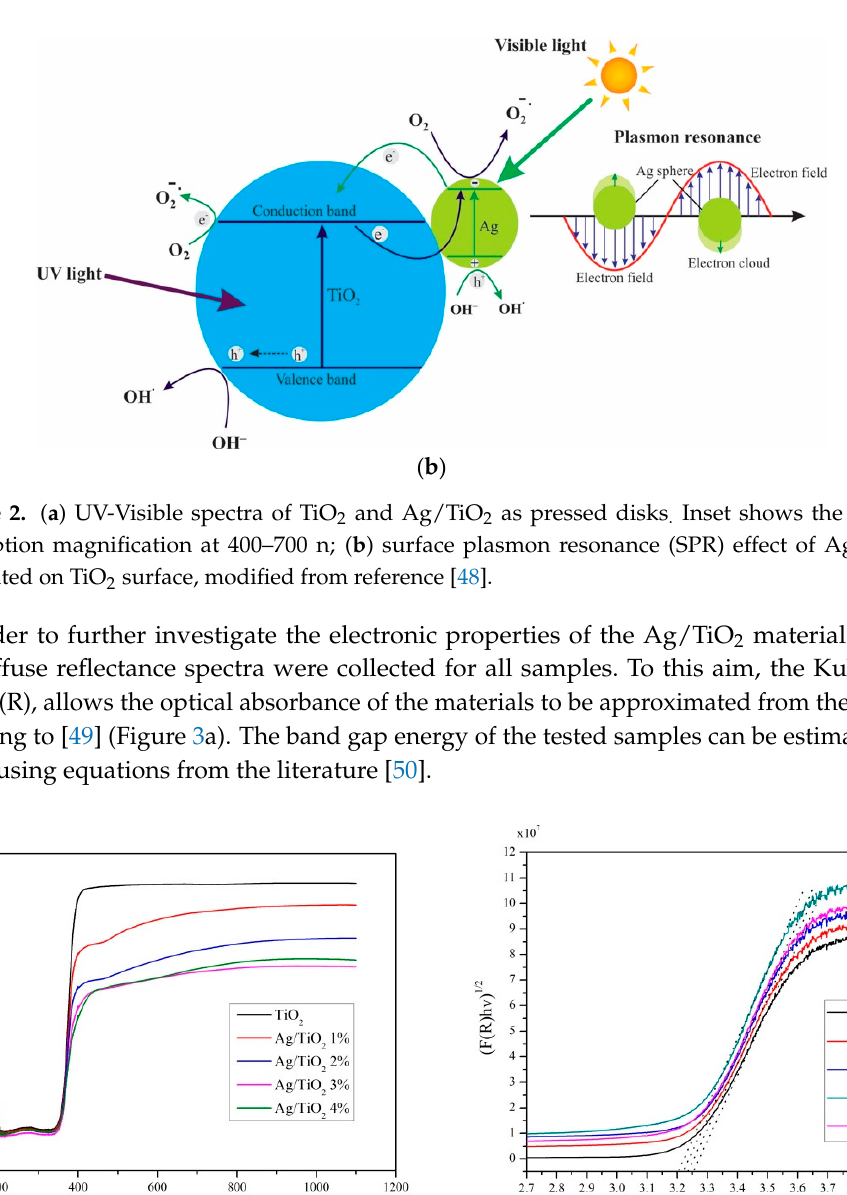
Figure 3. ( a ) Diffuse reflectance spectra and ( b ) band gap calculation of TiO 2 and Ag/TiO 2 X% (X = 1– 4).